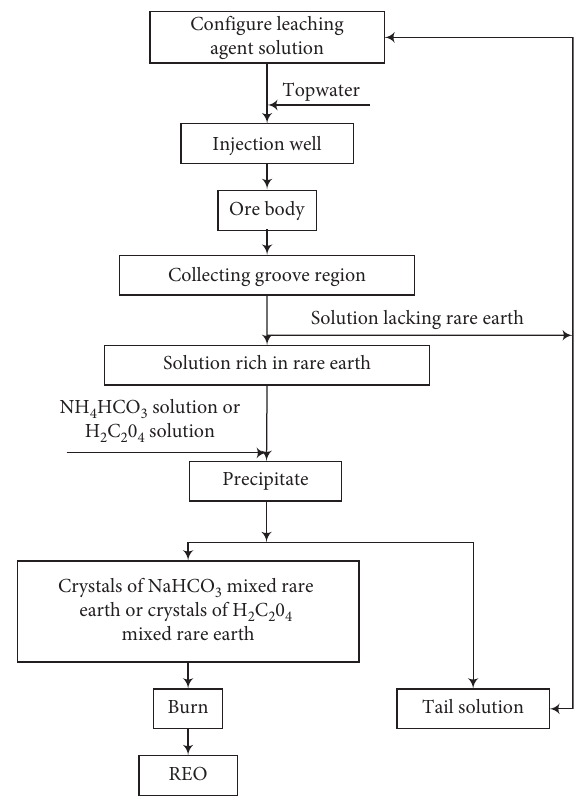
Figure 3: Weathered crust elution-deposited rare earth ore third-generation process.